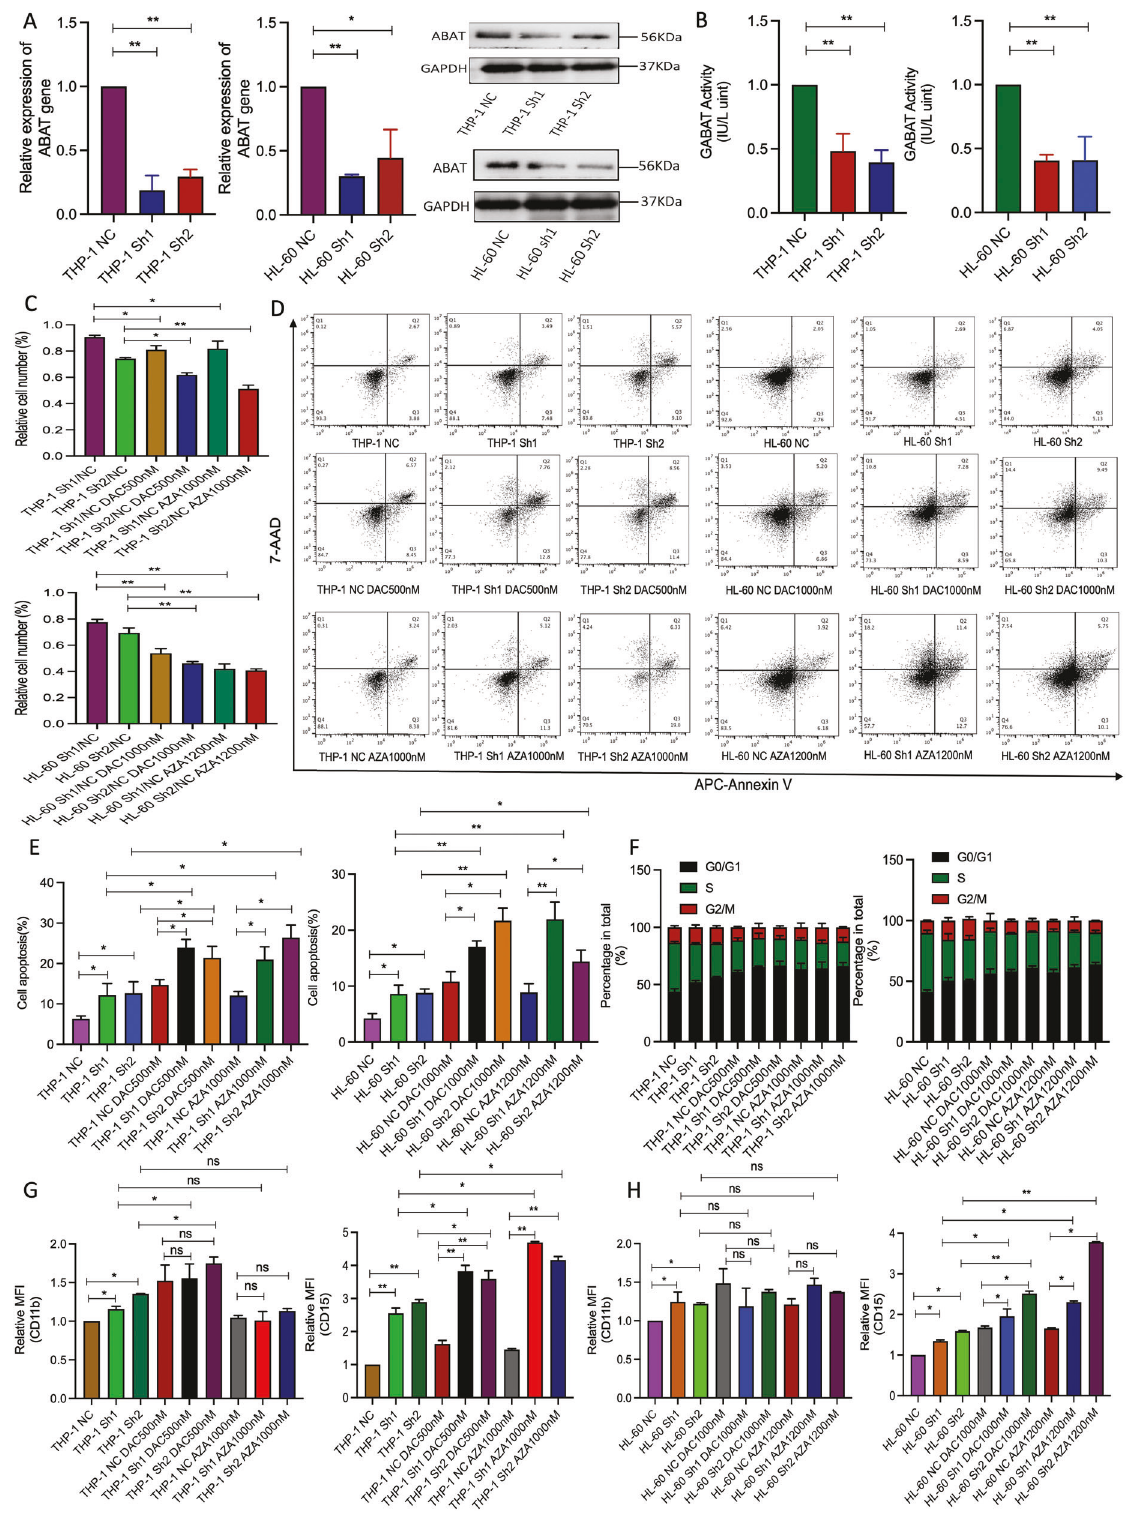
Fig. 1 Functional analysis of THP-1 and HL-60 cells with ABAT gene knockdown and HMAs treatment. A mRNA and protein expression of ABAT gene in THP-1 and HL-60 cells after ABAT interference. B GABAT enzyme activity in both cell lines with ABAT knockdown. C Evaluation of relative cell number in ABAT silenced cells treated with HMAs. Representative fi gures ( D ) and percentage ( E ) of apoptosis in ABAT silenced cells treated with HMAs. F Cell cycle analysis after ABAT interference and HMAs treatment. Relative expression of CD11b and CD15 in ABAT silenced THP-1 ( G ) and HL-60 ( H ) cells with HMAs treatment. Data were represented as mean ± SEM from three biological samples. * P < 0.05, ** P < 0.01. Student ’ s t -test (two groups) or one-way ANOVA analysis followed by Dunnett ’ s test (multiple groups). ns. not signi fi cant.